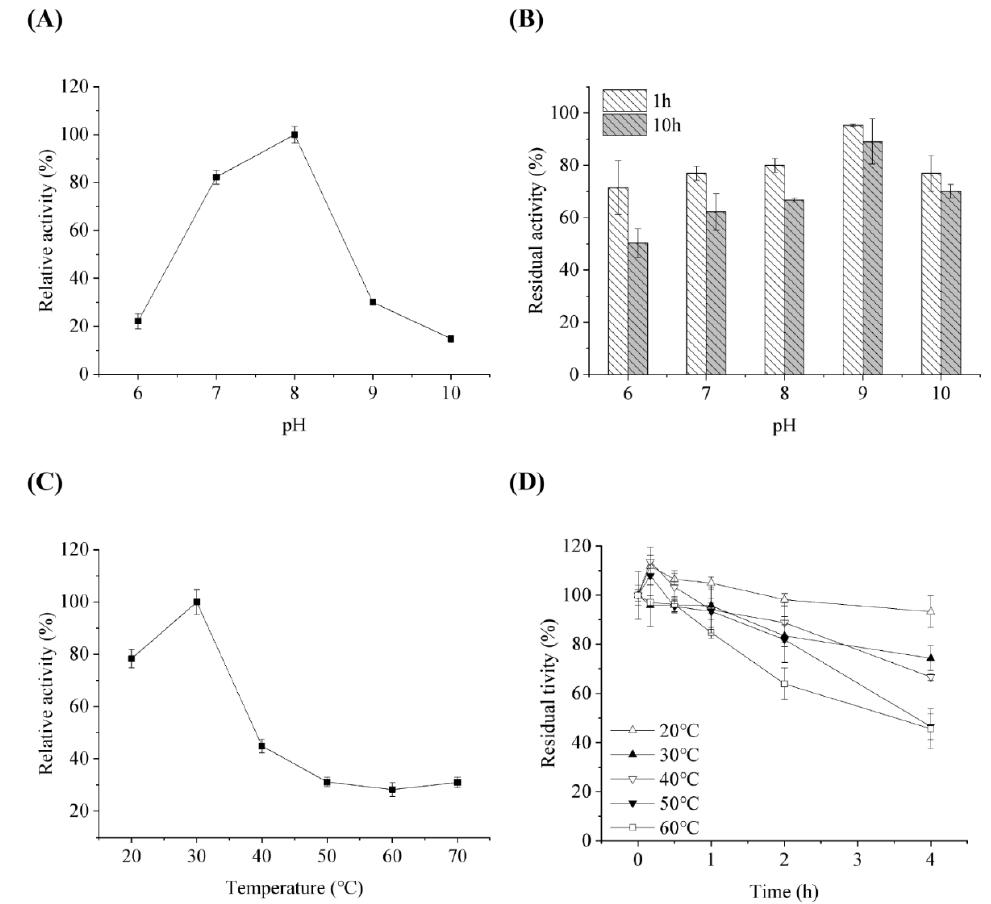
Figure 3. Influence of pH on enzymatic activity ( A ) and stability ( B ) of Sc LPMO10G against 2,6-DMP. For ( A , B ), the activity at pH 8 and initial activity were set at 100%, respectively. Influence of temperature on enzymatic activity ( C ) and stability ( D ) of Sc LPMO10G against 2,6-DMP. For ( C , D ), the activity at 30 °C and initial activity were set at 100%, respectively. All experiments were performed in triplicate and standard deviation was analysed (SD, n = 3).